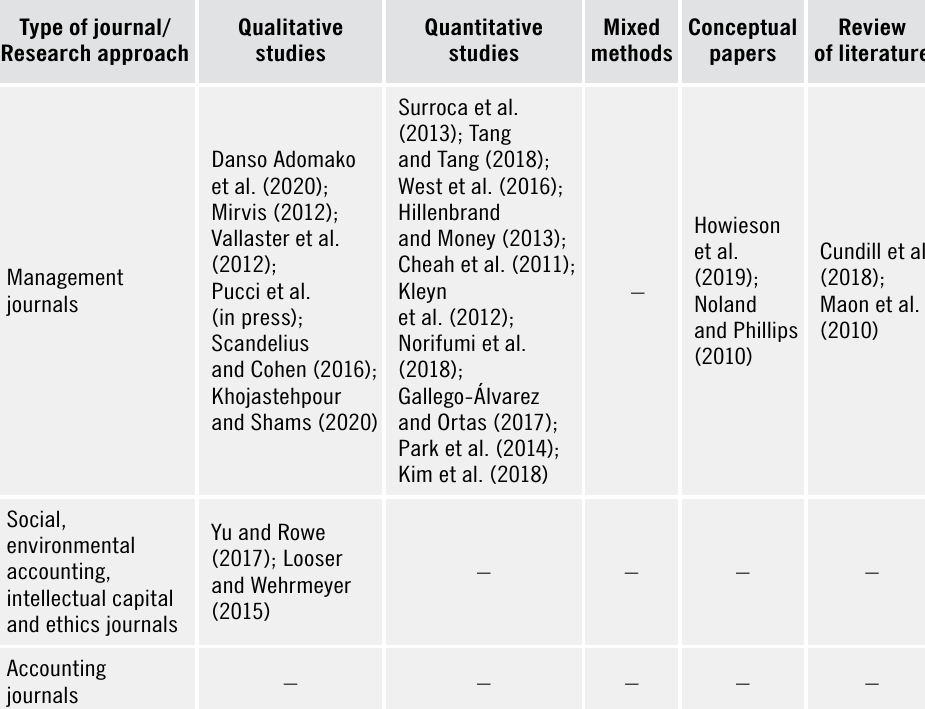
Table 2. Reviewed studies on stakeholder engagement in social practices, by journal type and research